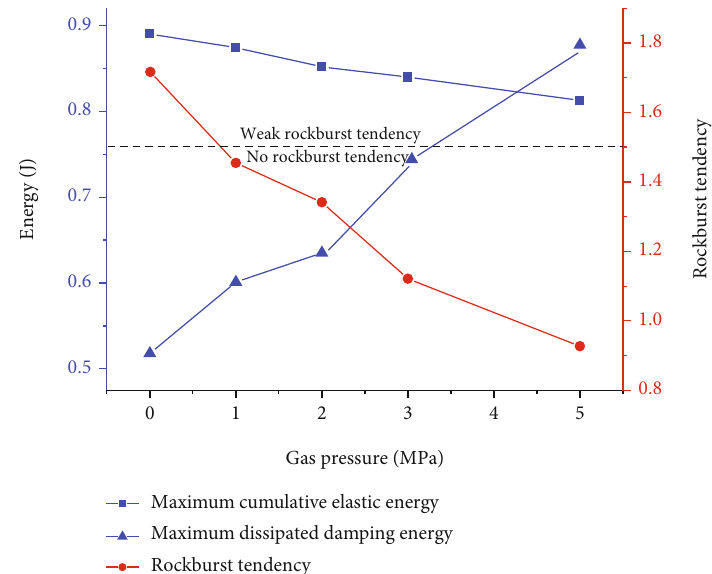
Figure 15: Changes of the rockburst tendency and energy of coal samples with di ff erent gas